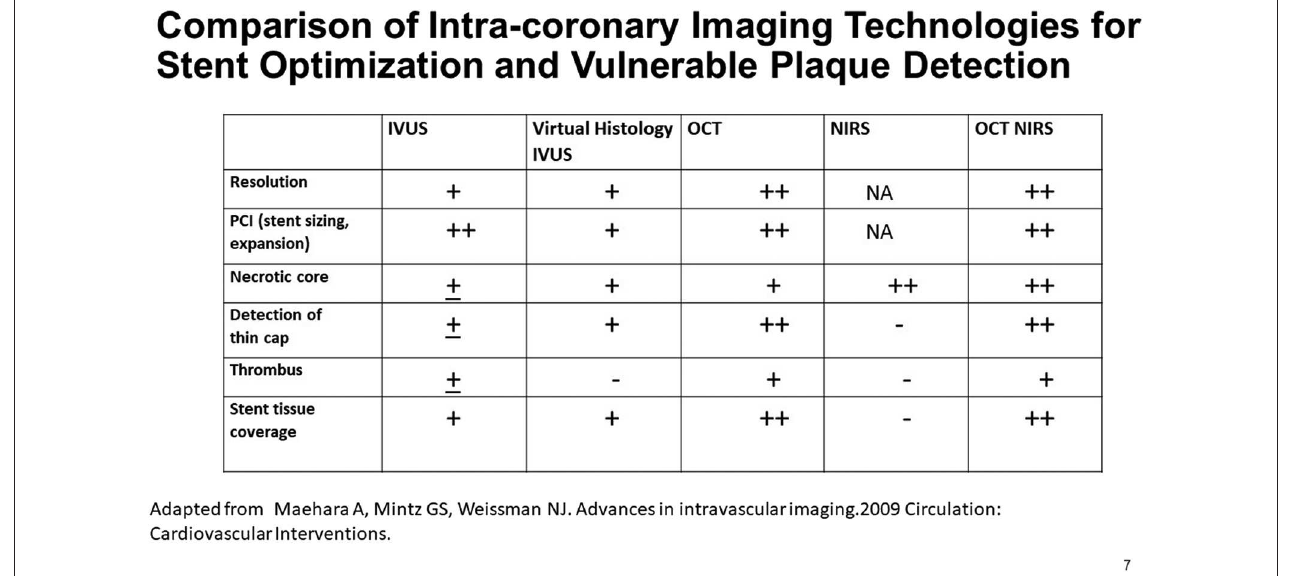
FIGURE 7 | A comparison of the capabilities of multiple imaging modalities for the detection of various features of interest in a coronary artery. Adapted from Maehara et al. (51).